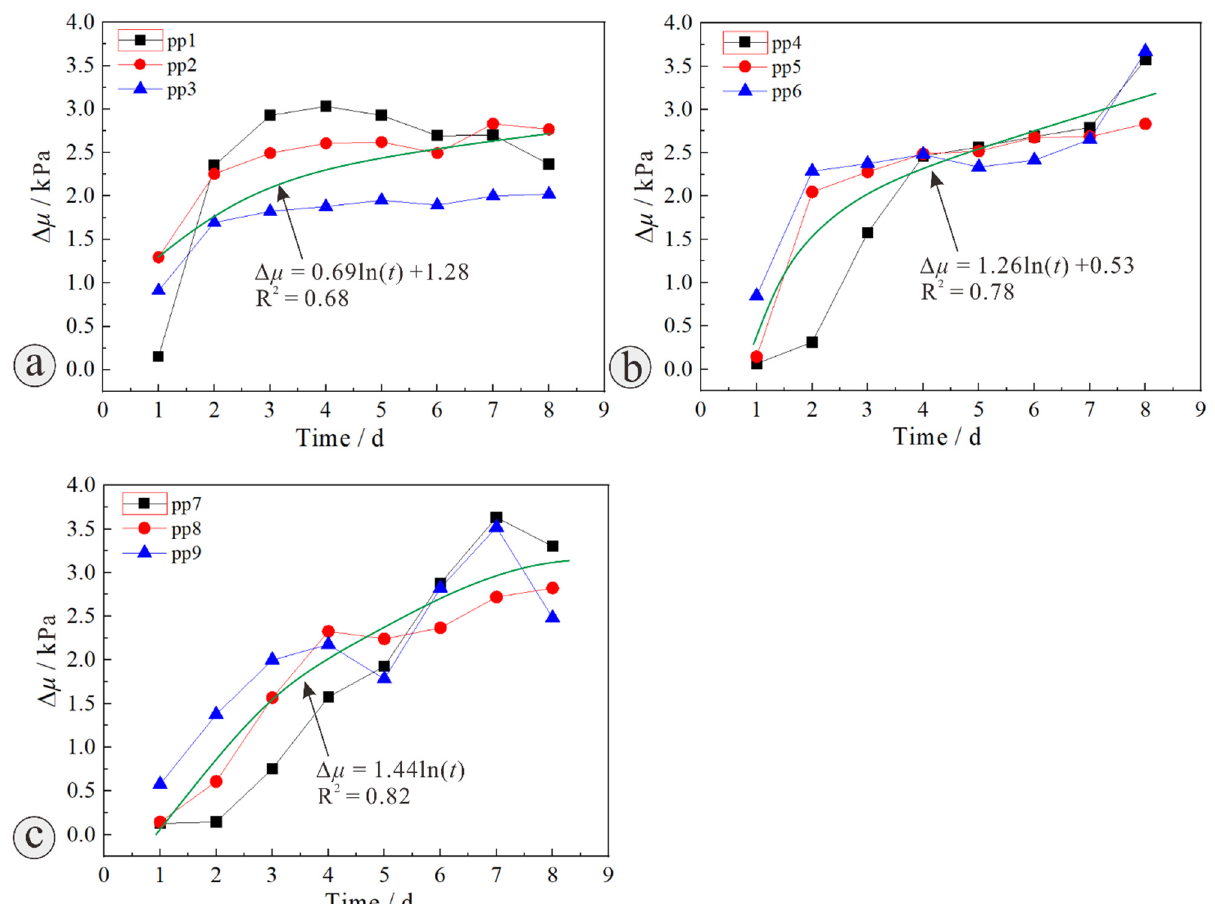
Figure 11. Daily maximum increment of pore pressure increment at different measuring points ( a ) H1 = 1.0 m, ( b ) H2 = 0.8 m and ( c ) H3 = 0.4 m.